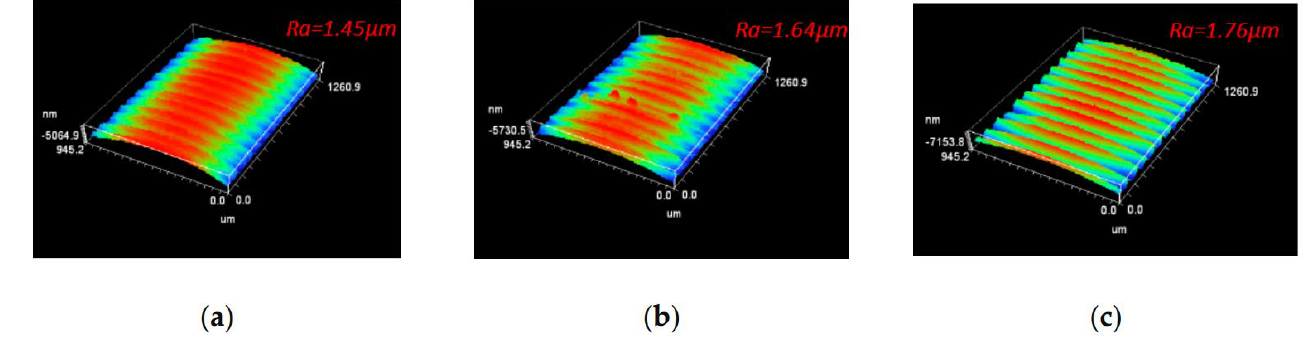
Figure 30. The Surface Roughness Profile of Workpiece: ( a ) d = 80 µ m micro-hole tool; ( b ) d = 120 µ m micro-hole tool; ( c ) non-textured tool [78].